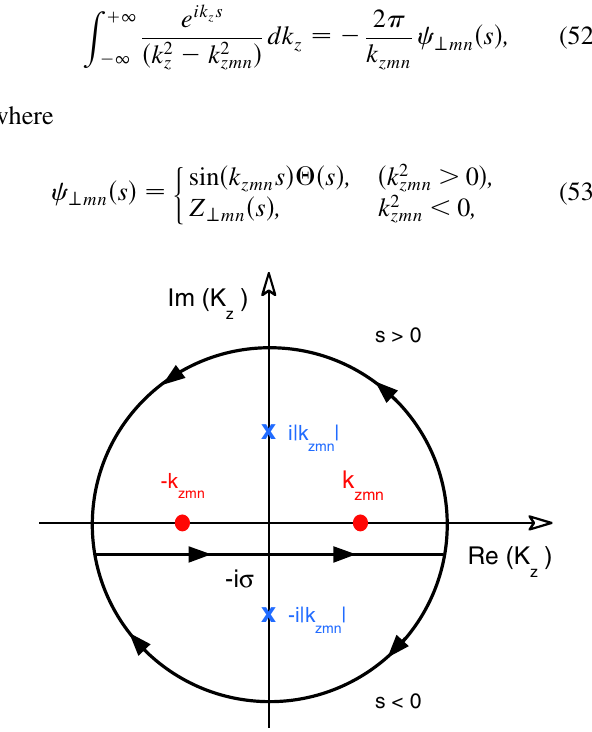
plane. There z (cid:2) (cid:5) i(cid:11) in the z